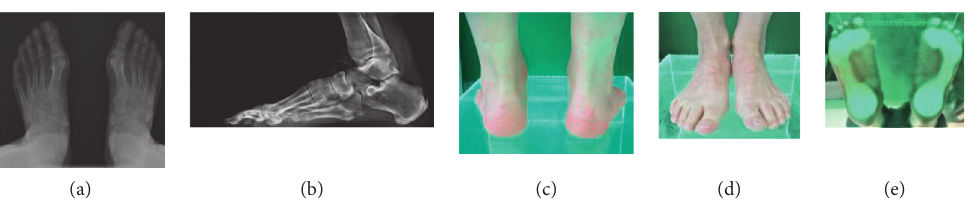
Figure 1: (a–e) Results of imaging tests (X-ray) and podoscopic tests: patient no.1. (a). Dorsal-plantar foot X-ray: hallux valgus, subluxation of sesamoid bones, overloaded cuneometatarsal joint, and osteophytes in the area of navicular bone.(b) Lateral X-ray: Achilles tendon enthesopathy and numerous calcifications. (c) Posterior picture: ankle joint and hindfoot evaluation. (d) Anterior picture of the feet: assessment of toe positioning and deformation. (e) Plantar photo on the podoscope: evaluation of plantar part of the foot and height measurement of the longitudinal